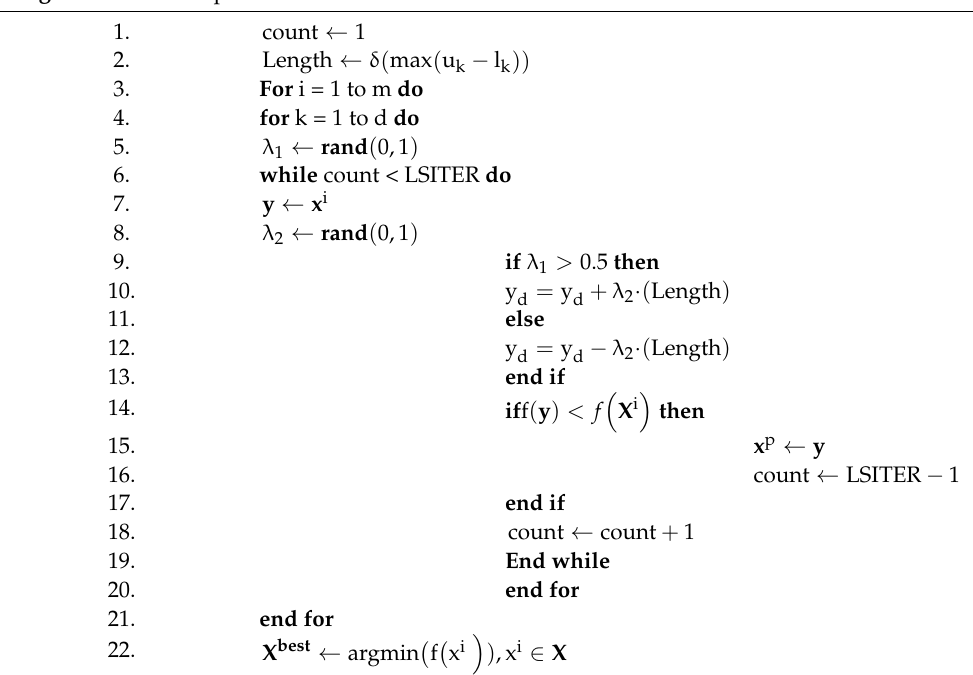
Algorithm 3: Find optimized threshold